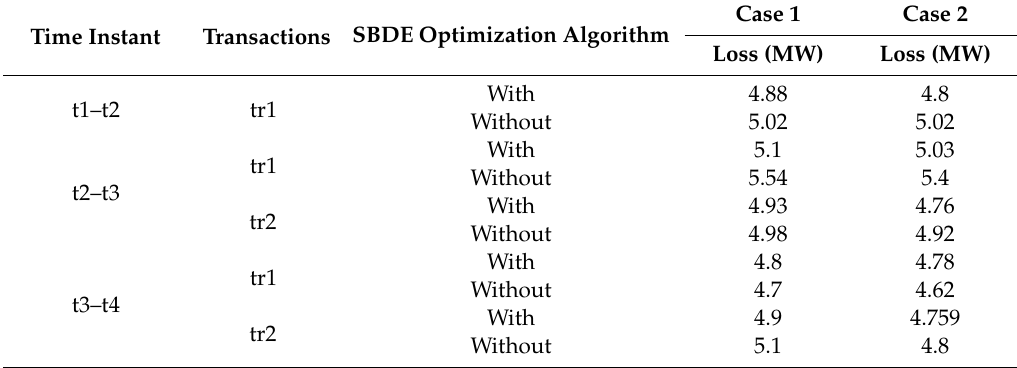
Table 6. System losses of di ff erent